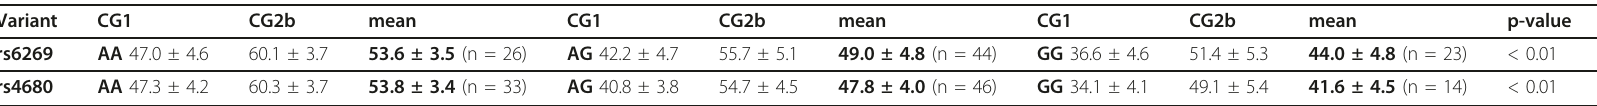
Table 3 S-COMT methylation [% ± SD] with respect to COMT genotype in Blood DNA (blood donors)